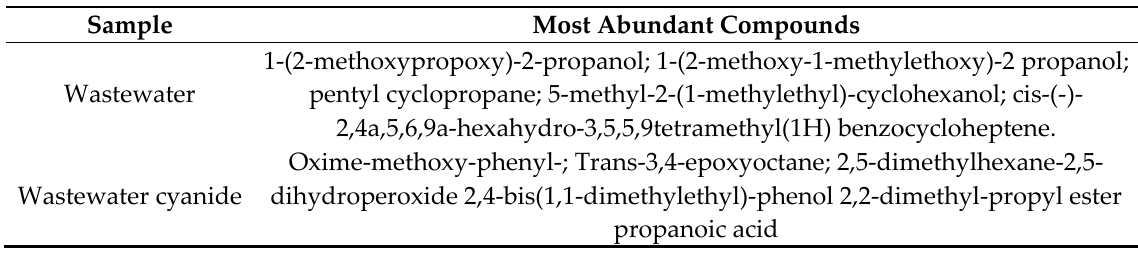
Table 1. Table showing the most representative VOCs in each